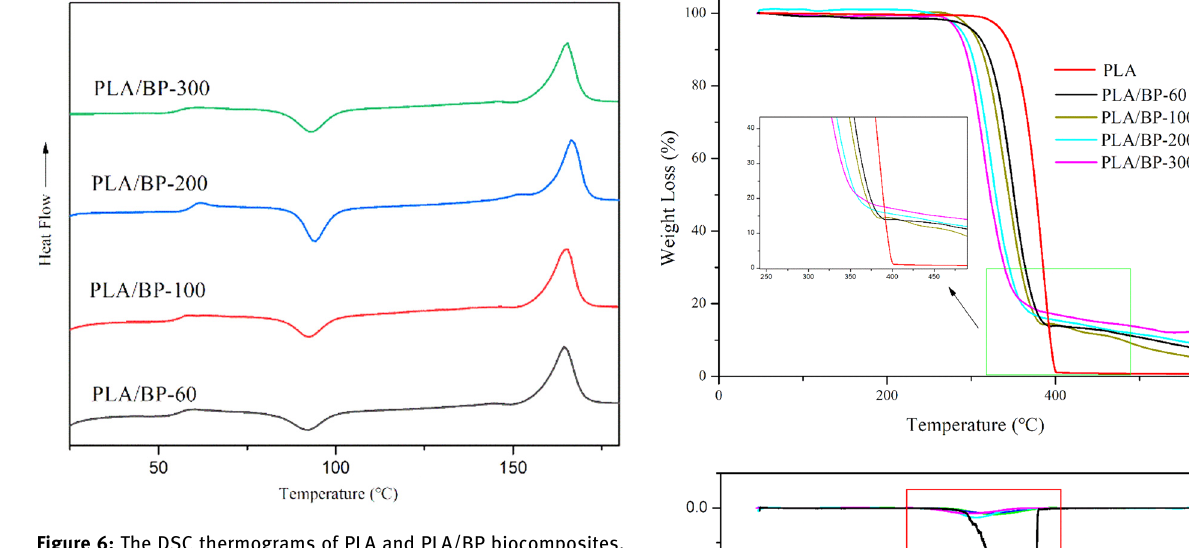
Figure 6: The DSC thermograms of PLA and PLA/BP biocomposites.